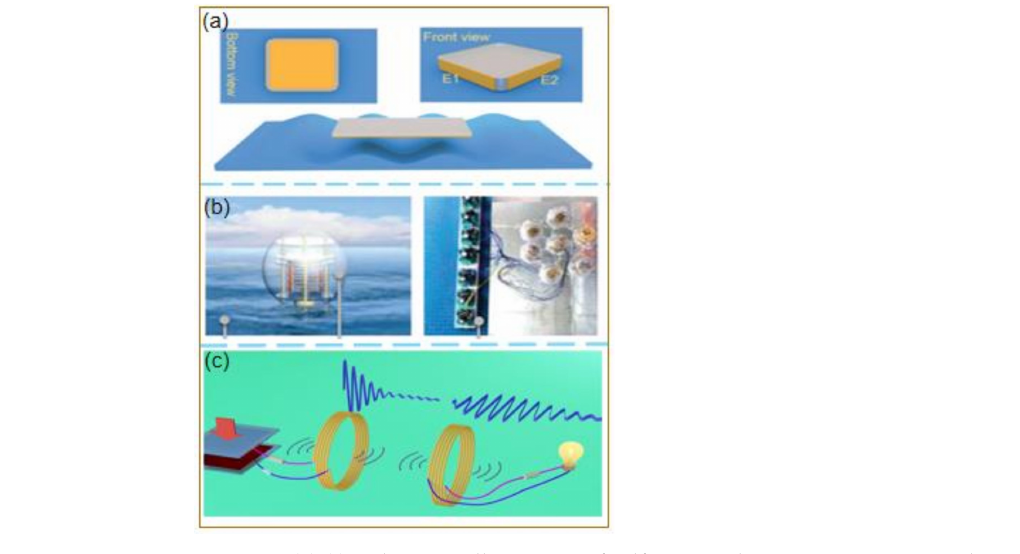
Figure 4. ( a ) (I): Schematic illustration of self-powered motion vector sensor based on DC-TENG, (II): Schematic illustration of the conventional self-powered sensors based on AC-TENG [101]; ( b ) Schematic illustration of a single spherical TENG with spring-assisted multilayered structure float- ing on the ocean surface [103]; ( c ) Magnetic resonance coupled wireless TENG [106]. ( a ) Reprinted with permission, LN: 5067420482614. ( b ) Reprinted with permission, LN: